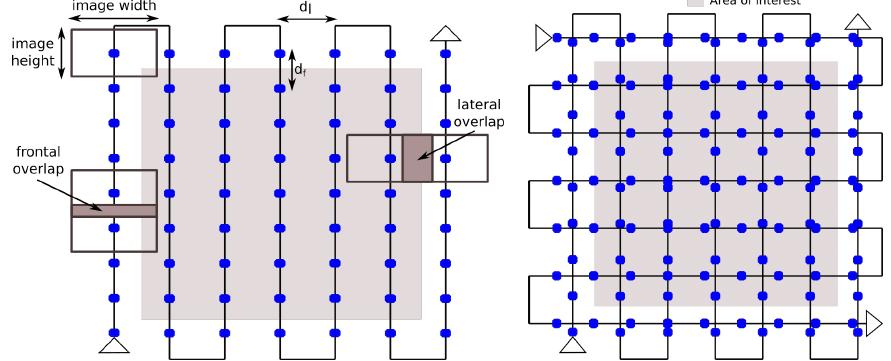
Figure 5. Two flight mission plans, in the left a simple grid and in the right a double grid plan. Blue dots represent the places were pictures are planned to be captured. Frontal and lateral overlap are also